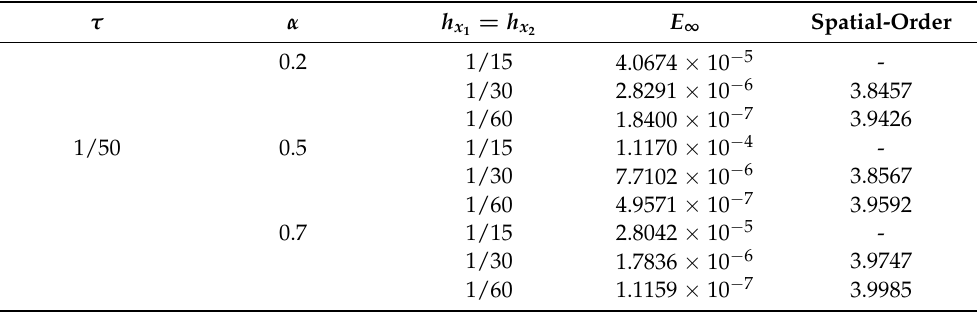
Table 3. The maximum error and average convergence order in spatial dimensions for Example 2.